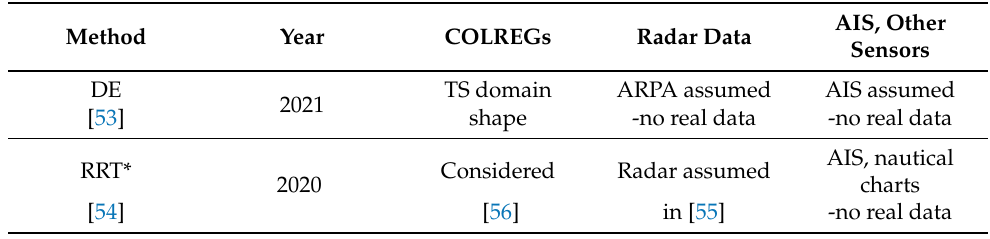
Table 7. A comparison of non-deterministic methods applying radar remote sensing and other sensors—part